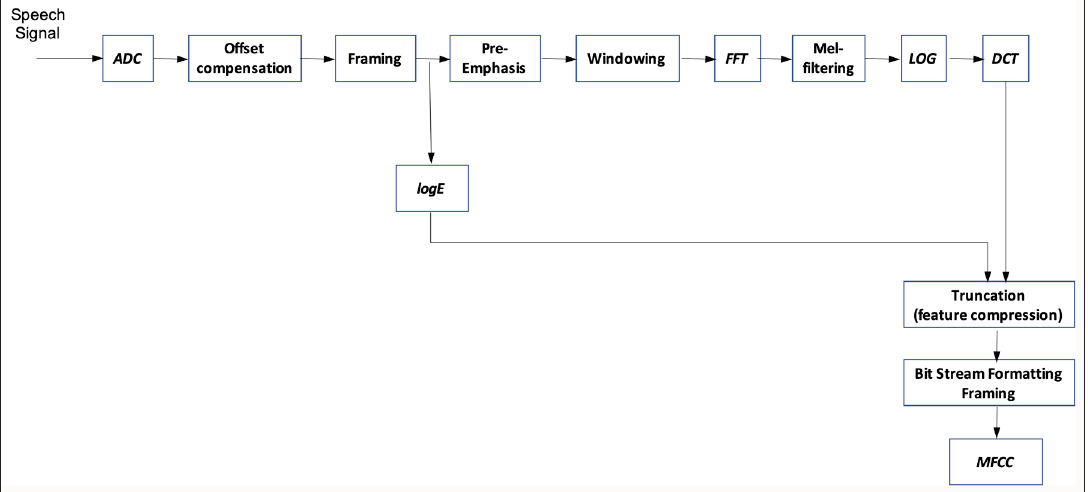
Figure 2: Block diagram of the ETSI Aurora standard for MFCC